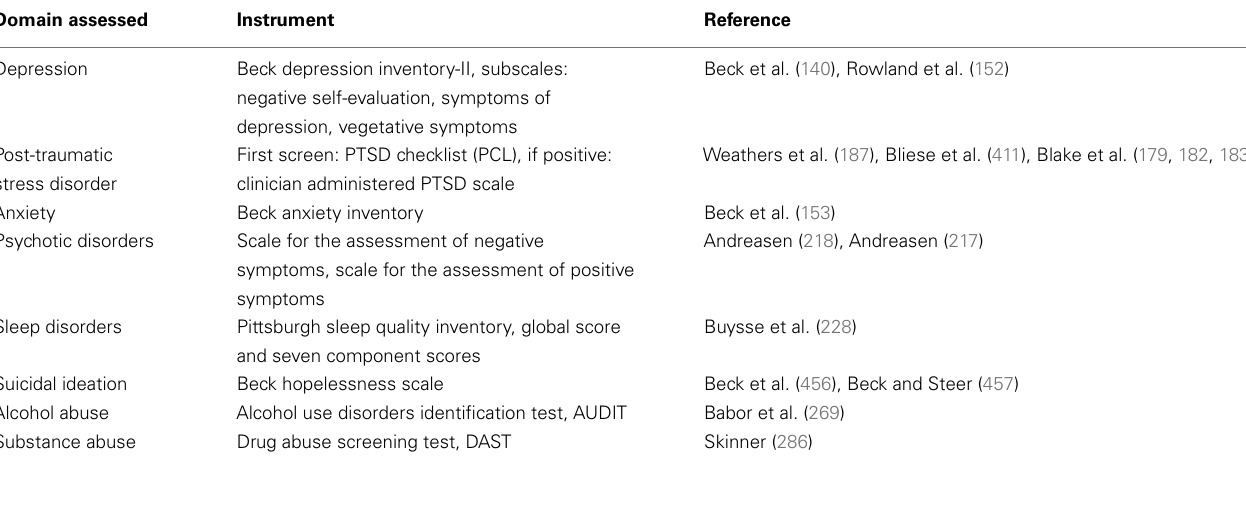
Table 16 |Additional instruments recommended for studies investigating traumatic brain injury and neuropsychiatric